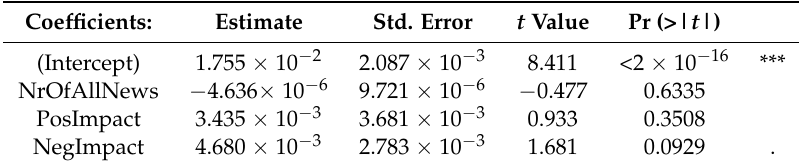
Regression analysis for volatility of the mean bond spread difference for France.